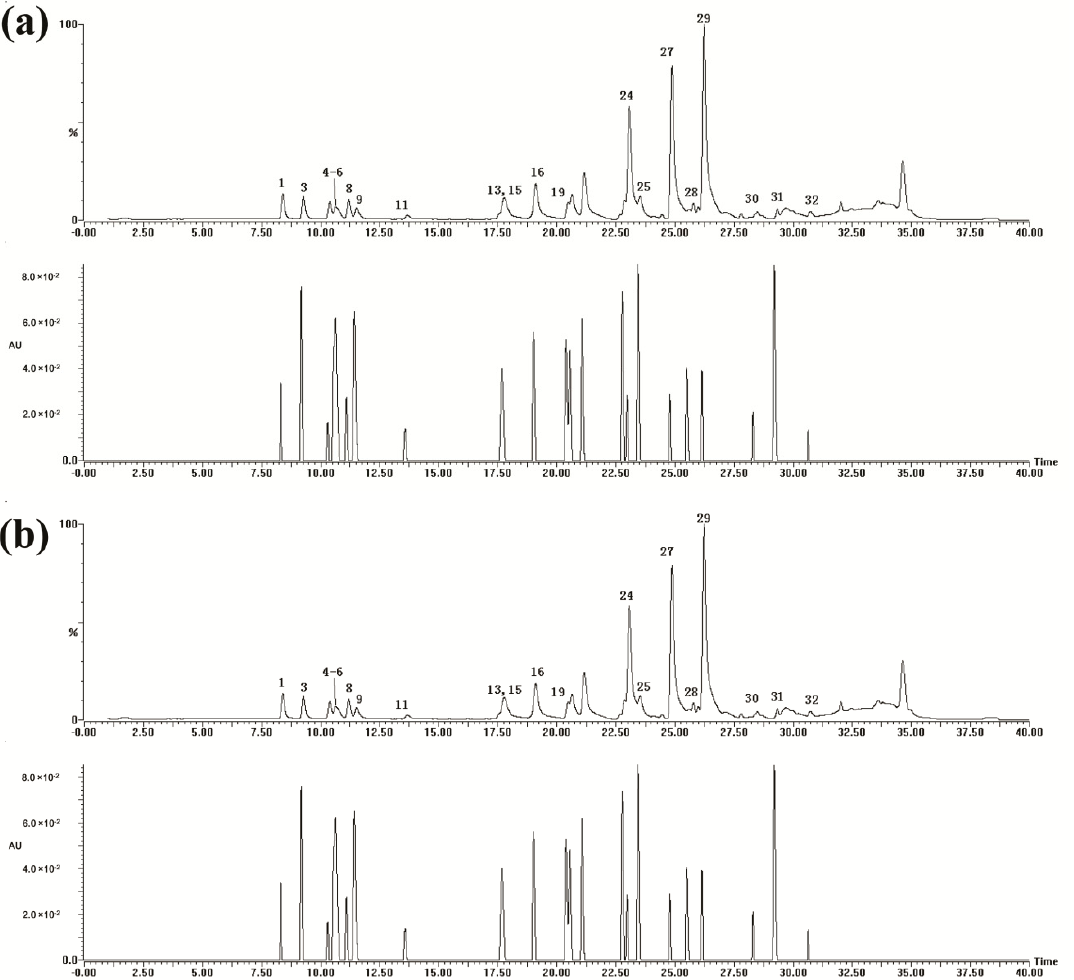
Figure 1. UPLC-DAD-ESI-MS chromatograms of standard reference mixture ( a ) and Danning Tablets sample ( b ) (Upper panel, LC-MS chromatogram at positive ion mode; lower panel, LC-UV chromatogram at 266 nm. Peaks 1–32 were same as those in Table 1).